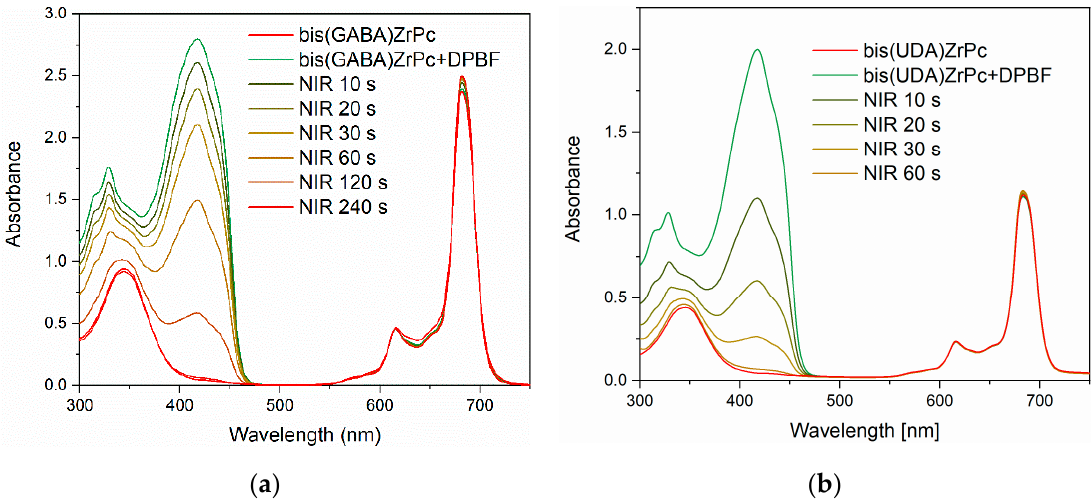
Figure 1. Absorption spectra of ( a ) bis(4-aminobutyrato)ZrPc and ( b ) bis(11-aminoundecannato)ZrPc solutions in dimethyl sulfoxide (DMSO) before and after addition of 1,3-diphenylisobenzofuran (DPBF), showing DPBF bleaching caused by singlet oxygen generation with increasing time of irradiation.